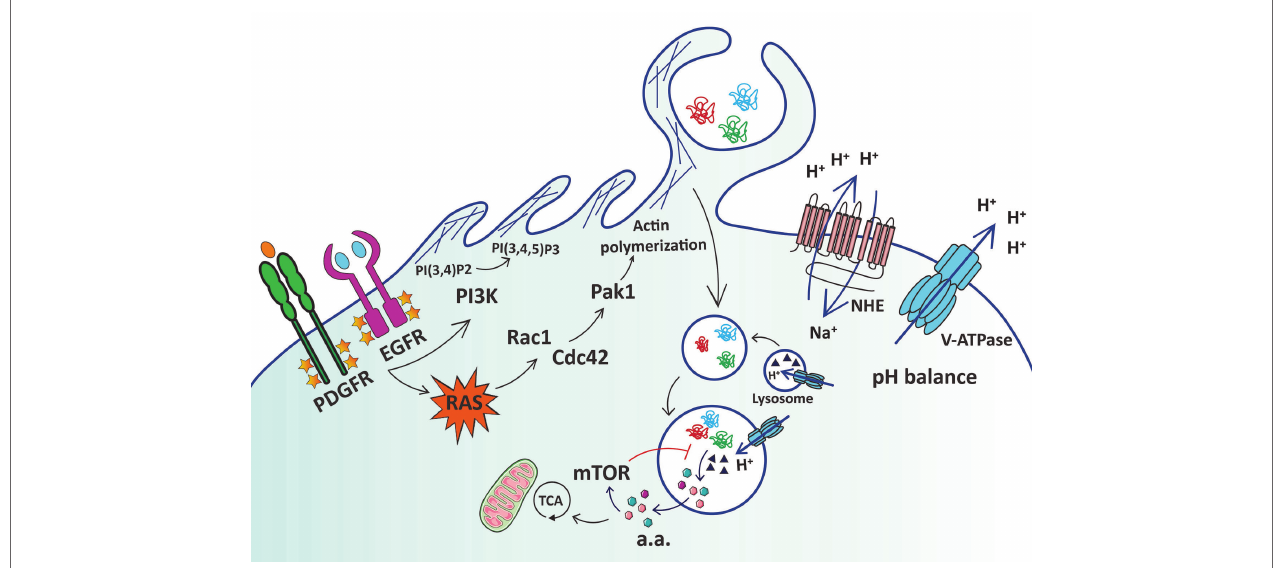
FiGURe 1 | Schematic representation of extracellular protein uptake via macropinocytosis in cancer cells. Ras activation, either by growth factor stimulation or through oncogenic mutation, leads to increased membrane ruffling and macropinocytosis via activation of Rac1 and Cdc42, which in turn stimulate p21-activated kinase 1 (Pak1) to induce actin polymerization. Activation of Rac1 and Cdc42 is sensitive to changes in submembranous pH, and the activity of Na + /H + exchangers (NHEs) and vacuolar H + -ATPase (V-ATPases) is crucial to maintaining pH homeostasis. Conversion of membrane phosphoinositides by PI3-kinase (PI3K) is also necessary for macropinocytosis. Macropinosomes containing extracellular proteins such as albumin and collagen are internalized and subsequently fuse with lysosomes. Lysosomal proteases ( ▲ ) allow the catabolism of extracellular proteins into free amino acids (a.a.) that can fuel the TCA cycle to promote cell growth and survival. mTORC1 finely regulates the utilization of extracellular protein-derived amino acids by inhibiting macropinocytosed protein catabolism when free a.a. are abundant. Yellow stars represent phosphorylation of growth factor